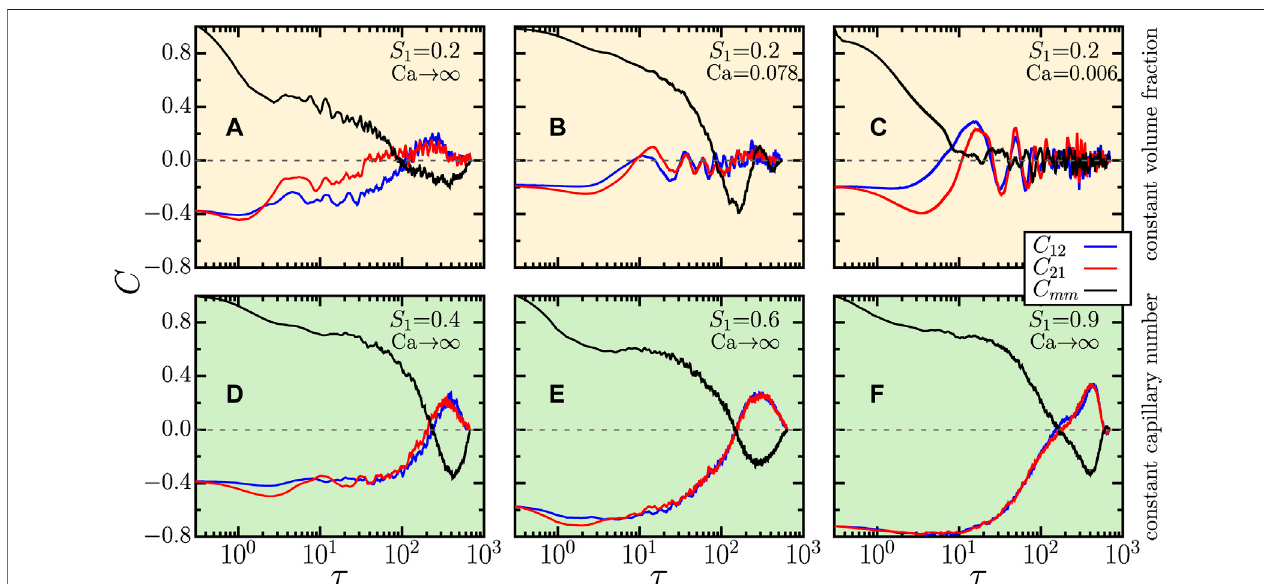
FIGURE2| Time correlation functionscomputed withthevelocitytimeseries ofthetwophases and themixture, likethoseshownin Figures1B,E ,for M =10and ∇ P =1.0 kPa/m. C 12 isthecross-correlationfunctionbetweenthevelocitytimeseriesofphase1andphase2,wheretheevolutionofphase2isshiftedforwardintimeby τ relative tophase 1,while C fl uid.Thetoppanelsshow theeffectofdecreasing thecapillary 21 istheoppositecase. C mm istheautocorrelation ofthevelocityoftheentire number from Ca → ∞ in (A) to 0.078 in (B) , and to 0.006 in (C) , while the volume fraction of phase 1 is kept at S 1 = 0.2. In (D – F) we keep Ca → ∞ , as in (A) , but increase the saturation of the less viscous phase systematically from S 1 = 0.4 to 0.6, and to 0.9,